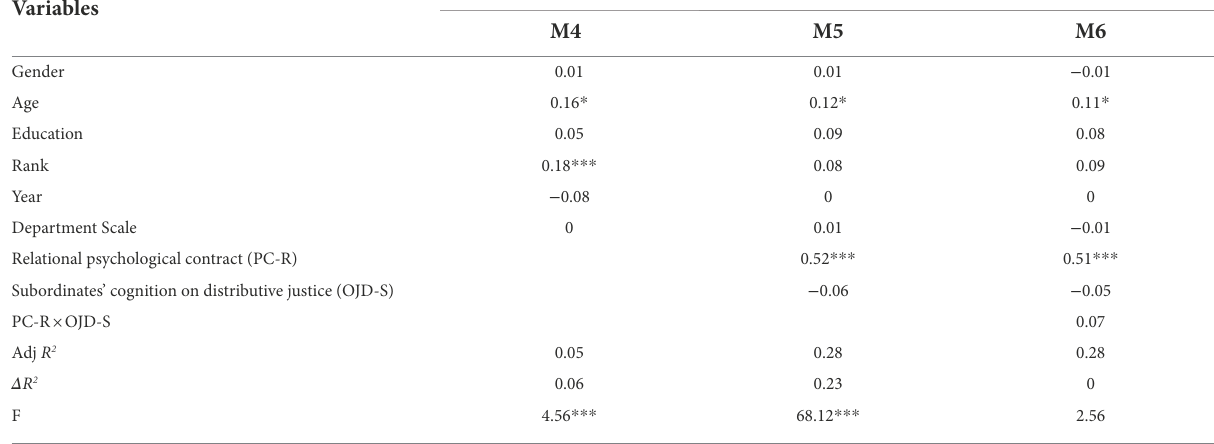
Dependent variable: Organizational identification (OI)